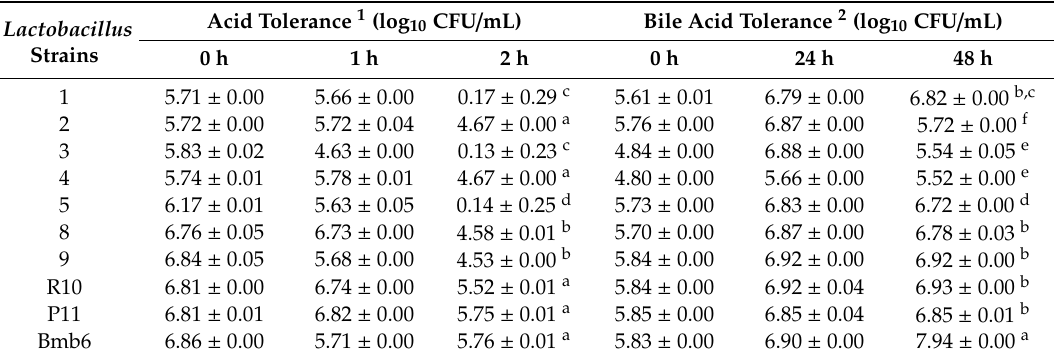
Table 3. Tolerance of Lactobacillus strains to acidic and bile acid conditions.